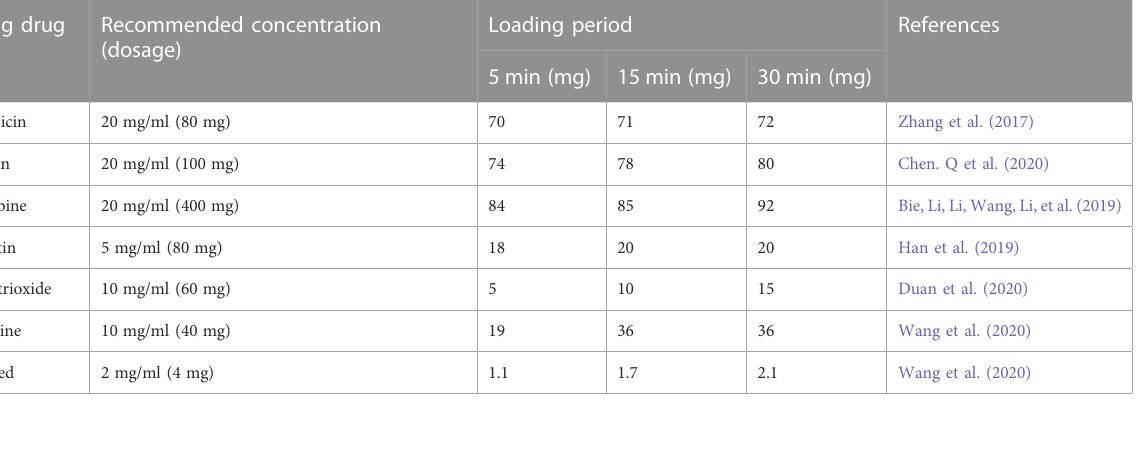
TABLE 1 Loadable chemotherapy drugs and dosage recommendations.